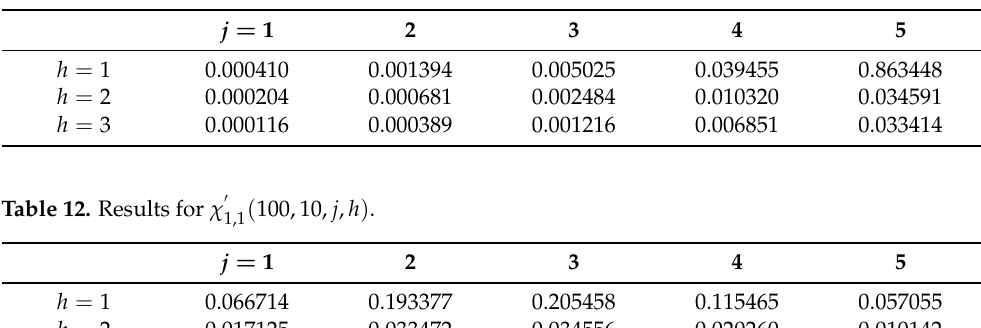
Table 11. Results for χ (cid:48)